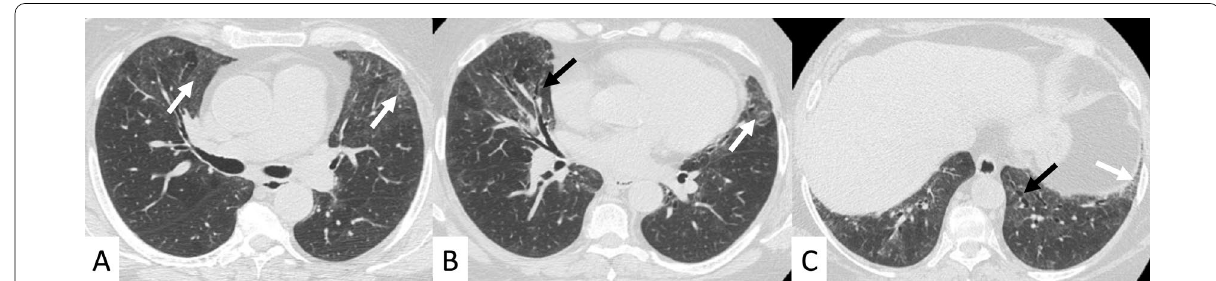
Fig. 9 Typical NSIP pattern in an SSc patient. A Ground-glass opacities and fine reticulations (white arrows), predominantly located in peripheral regions; in B , C traction bronchiectasis are also depicted (black arrows)